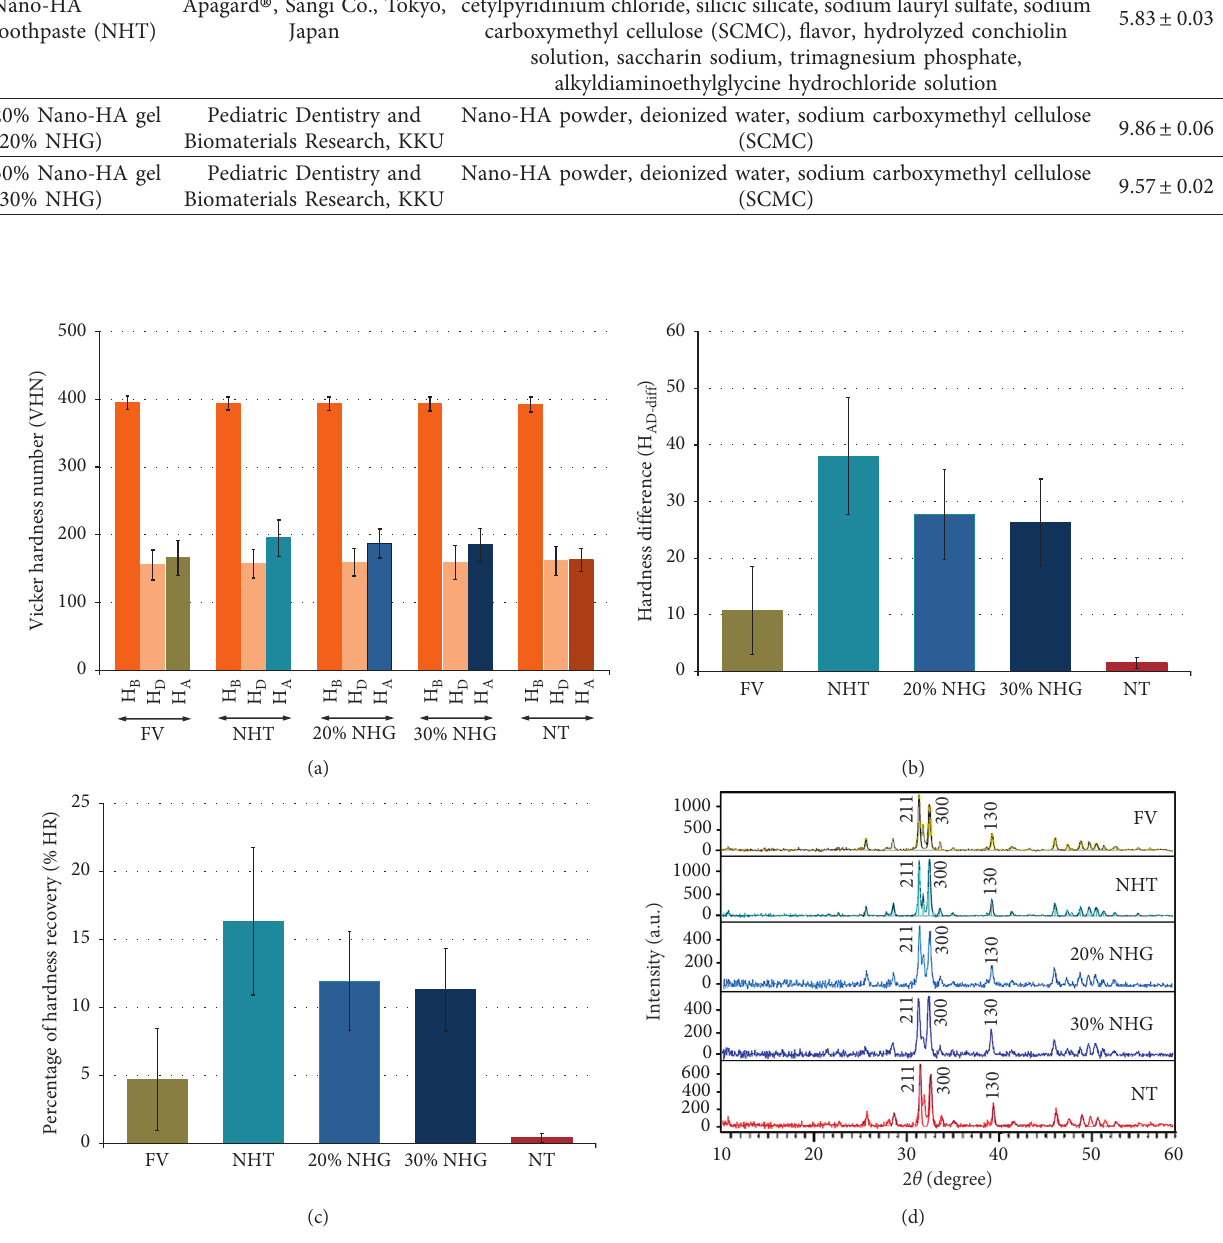
Figure 2: (a) Mean and standard deviation of hardness at baseline ( H B ), hardness upon acid-activated demineralized process ( H D ), and hardness upon administration of the remineralizing agent ( H A ); (b) difference of hardness upon acid-activated demineralization and after application of remineralizing agents ( H AD-diff � H A − H D ); (c) percentage of hardness recovery (%HR); and (d) microscopic crystal structure of each group treated with fluoride varnish (FV), nano-hydroxyapatite toothpaste (NHT), 20% nano-hydroxyapatite gel (20% NHG), and 30% nano-hydroxyapatite gel (30% NHG) compared to no treated group